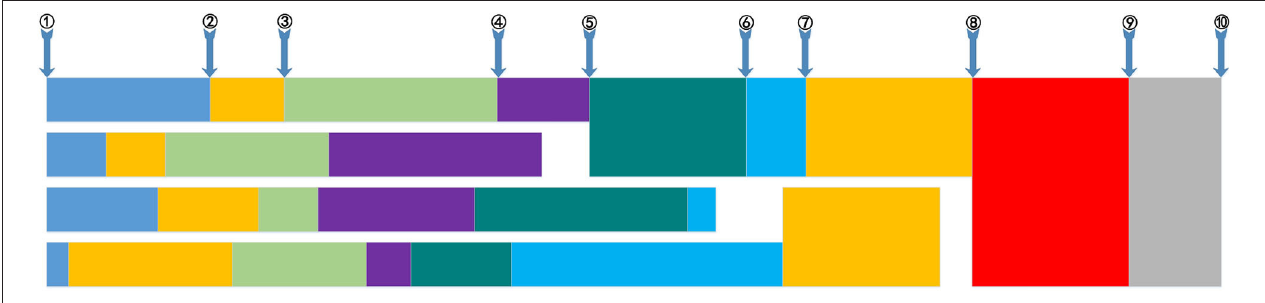
FIGURE 7 | Information-processing